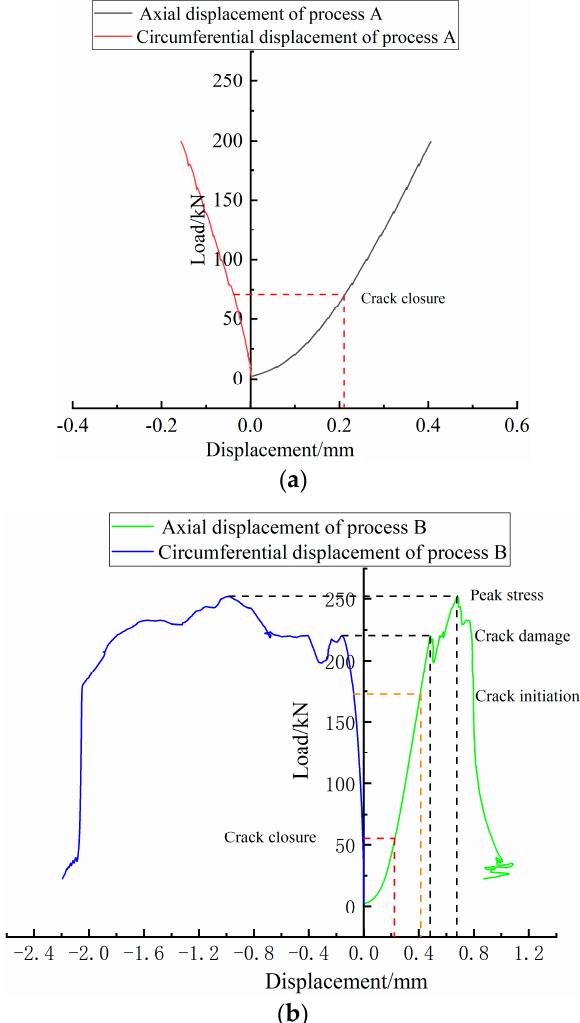
Figure 5. Displacement curve of rock sample during loading; ( a ) shows axial and circumferential displacement of the No.0 rock sample during loading; ( b ) shows axial and circumferential displacement of the No.3 rock sample during loading.